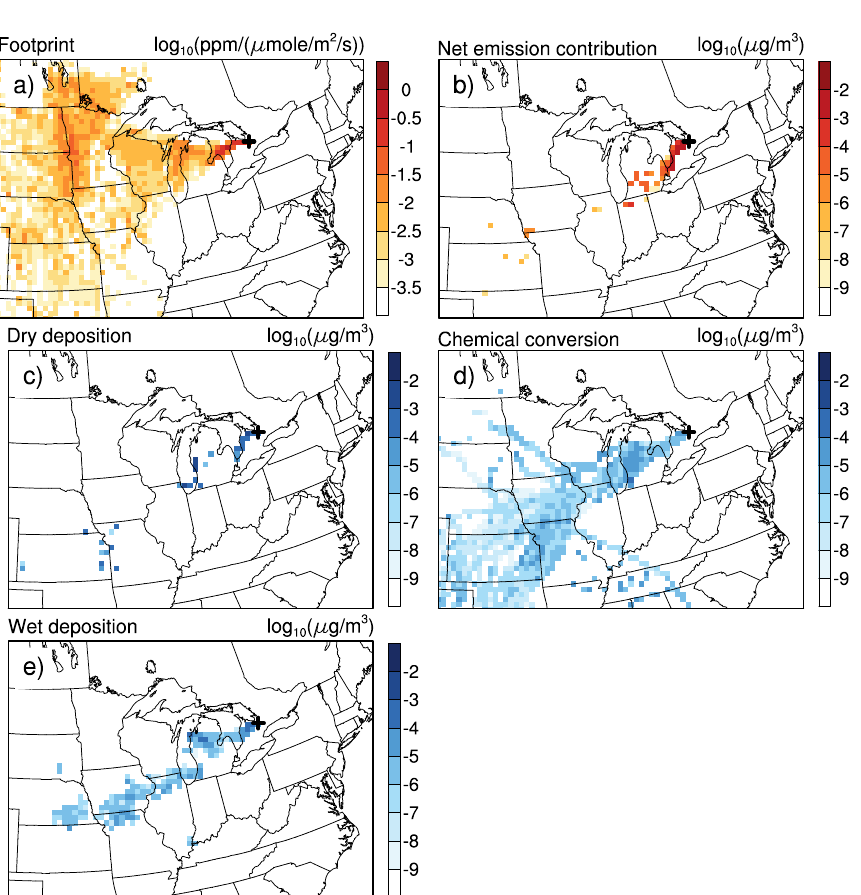
Fig. 6. Modeled upstream parameters and processes impacting NH 3 concentration simulated at Egbert (location indicated by “+”) at 18:00UTC on 2 July 2006, including: (a) footprint (i.e., the sensitivity of modeled NH 3 concentration at Egbert at that time to each upstream location); (b) net emission contribution (red color scale); (c) loss (blue scale) due to dry deposition; (d) loss due to chemical conversion;